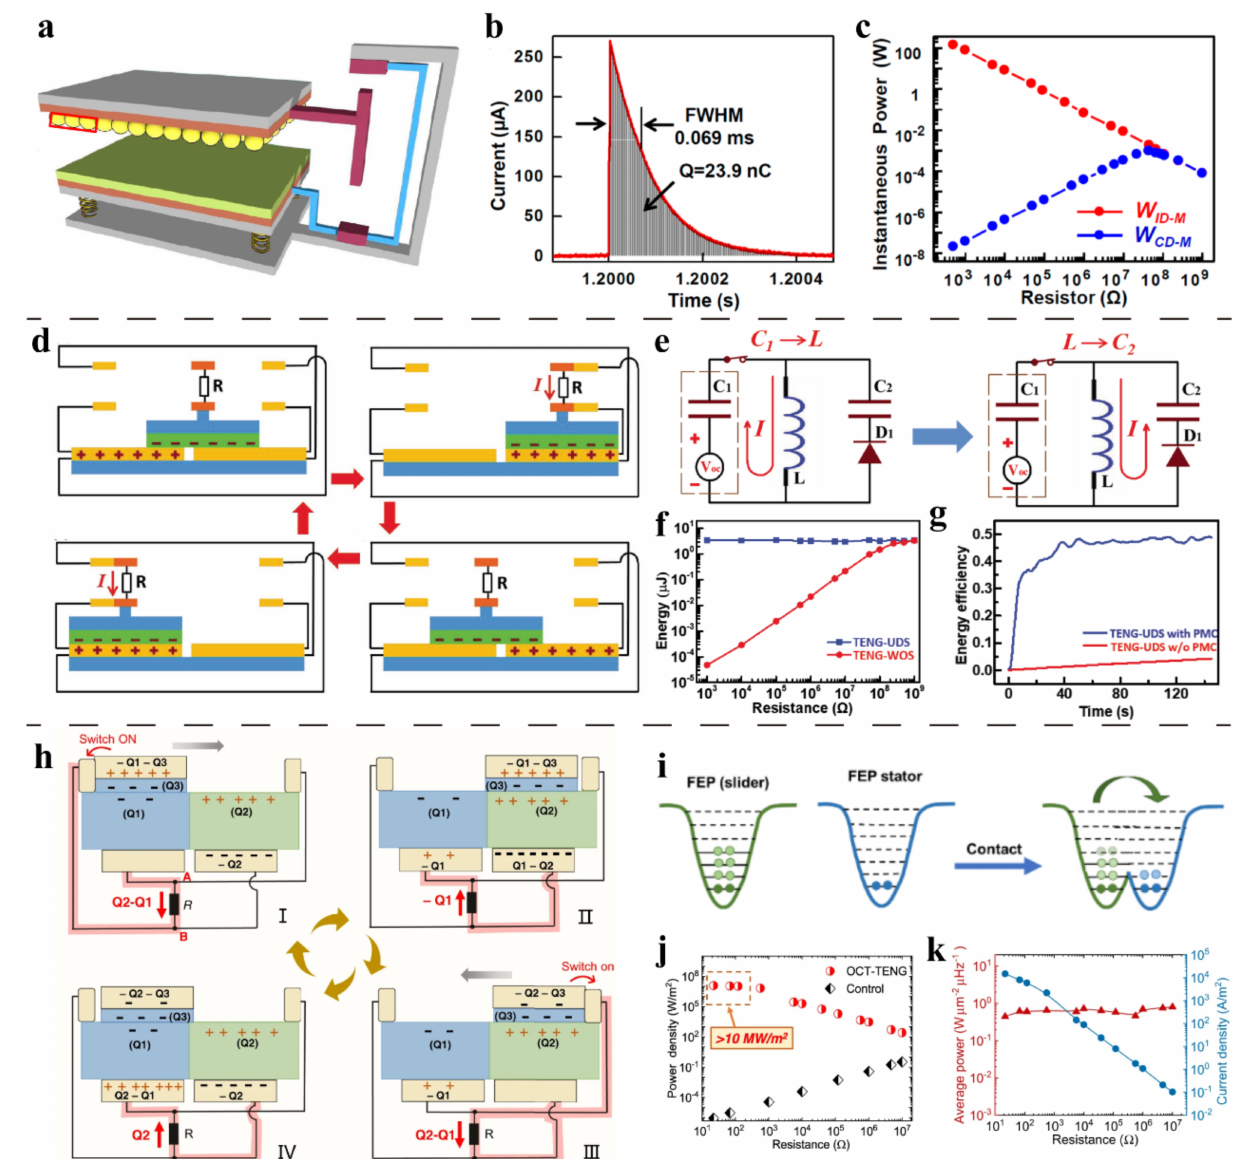
Figure 3. Power management with series travel switch. ( a ) Structure of the travel switch. ( b ) Pulse cur- rent at the switch-on moment. ( c ) Dependence of instantaneous power on resistor with/without travel switch. Reproduced with permission [59]. Copyright 2013, American Chemical Society. ( d )